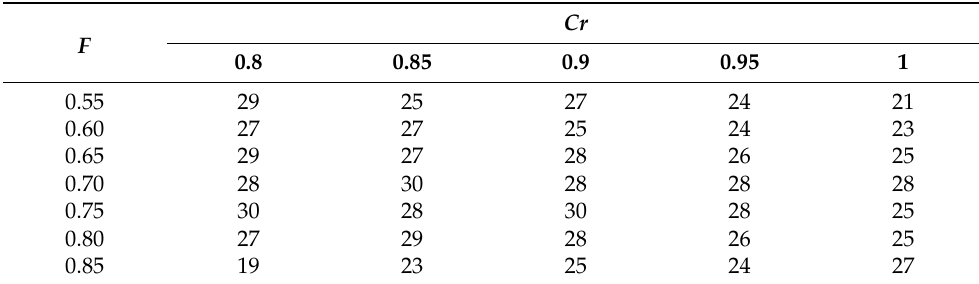
Table 3. The results of the strategy test. The number of successful optimizations of PSIIRC fitting after 30 runs of DE for each { F ; Cr } pair and the DE/best/1/bin strategy. F 0.8 0.85 0.9 0.95